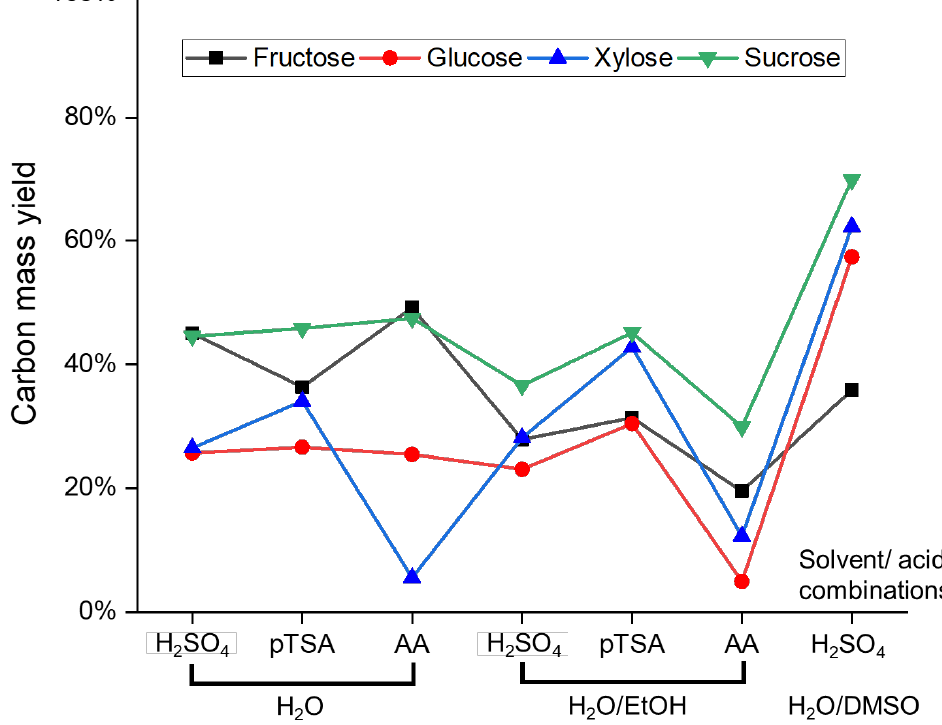
Figure 3. Overview of yields in humin formation experiments (determined with Equation (S1)).